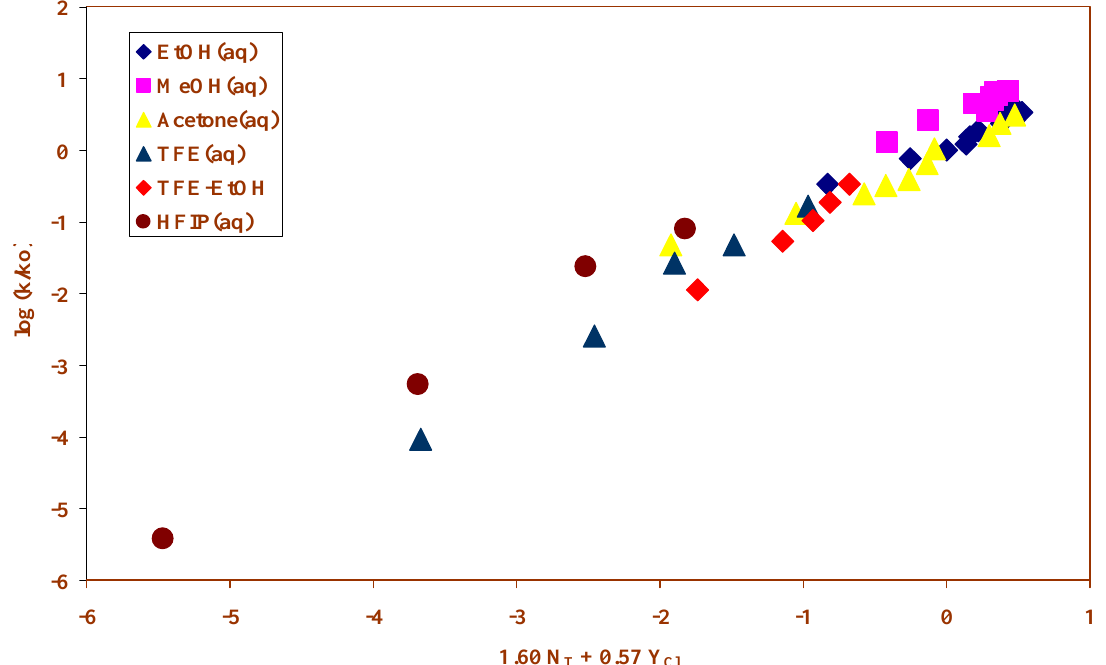
Figure 1. The plot of log (k/k